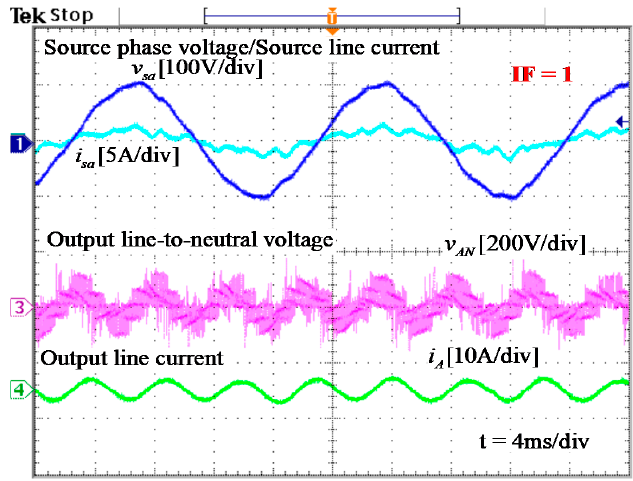
Figure 14. Source phase voltage / source current, output line-to-neutral voltage, and output line current at f o = 50 Hz ( Q = 0.1 < 0.375 ) , q = 0.5 with unity IPF compensation.